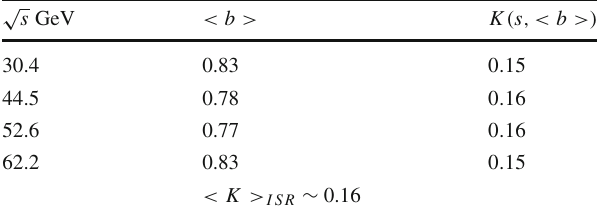
Table 2 Averaged impact parameter, < b > , at the ISR energies and the corresponding inelasticity values √ s